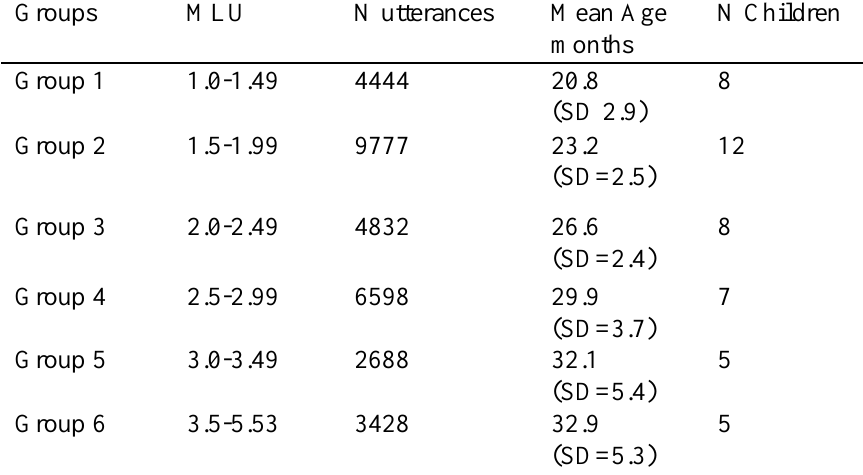
Table 2. Details of children’s productions across MLU groups